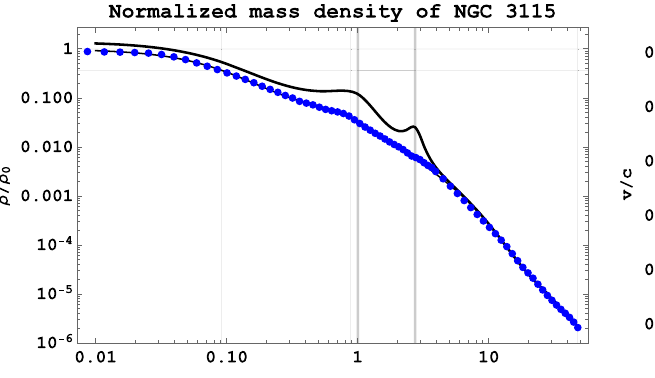
(the points correspond to the north following and the circles to the south preceding sides of the galaxy nucleus, respectively). The vertical lines in both graphics indicate the center positions of the two ring currents located near the inner edge of the disk region. The last measurement of the rotation curve is taken at l β = 4 .